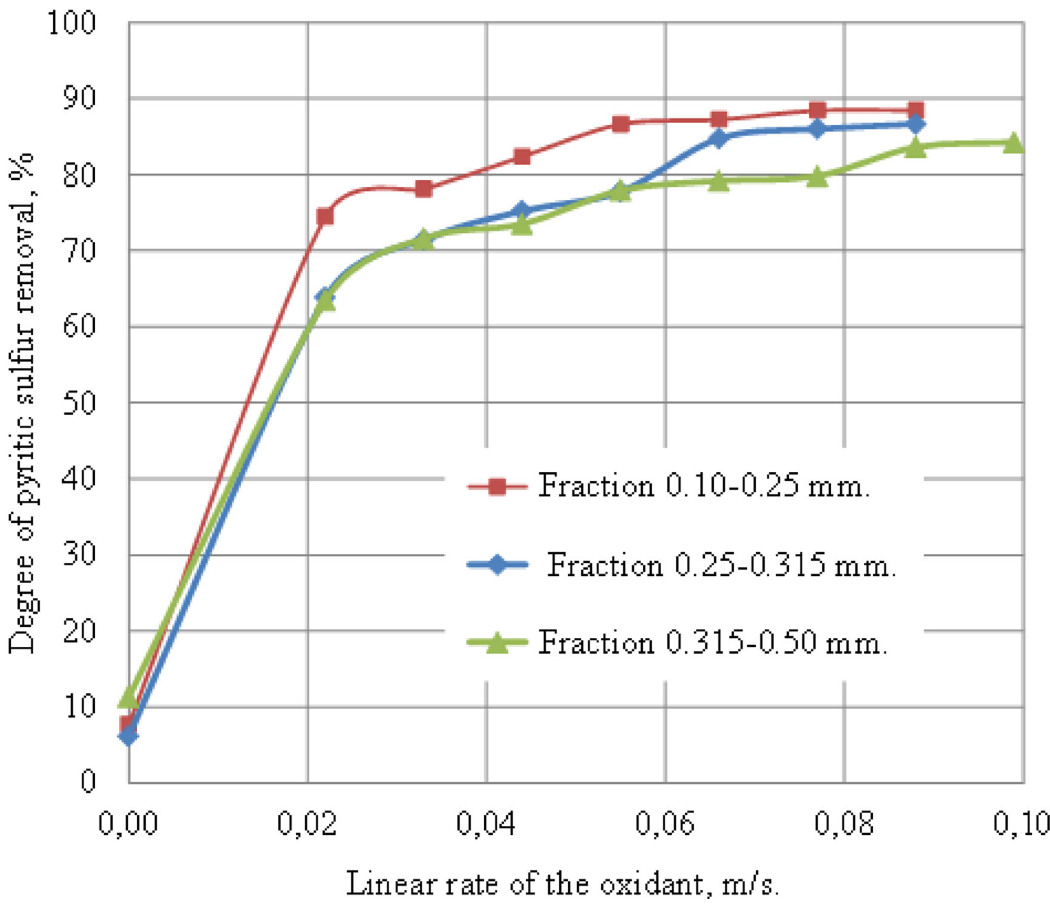
Fig. 8 The degree of pyritic sulphur removal versus OLV and coal particles’